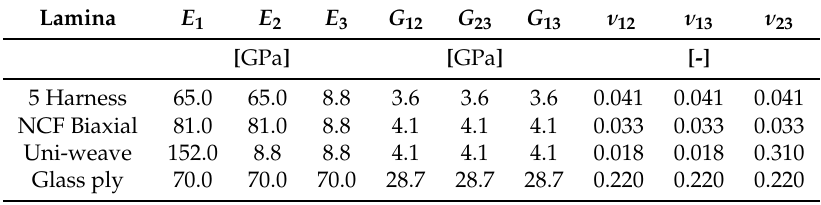
Table A2. Engineering elastic properties in the principal directions for the CFRP layered